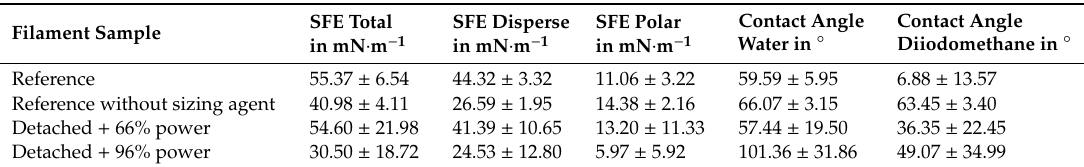
Table 2. Contact angles for the surface free energy (SFE)